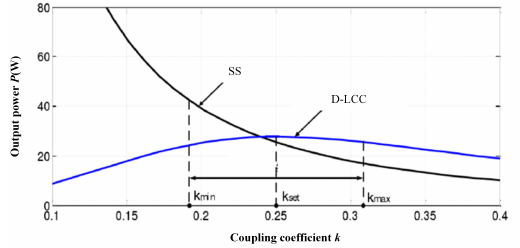
Fig. 1. The curve of SS and D-LCC topology output power as coupling coefficient k changes